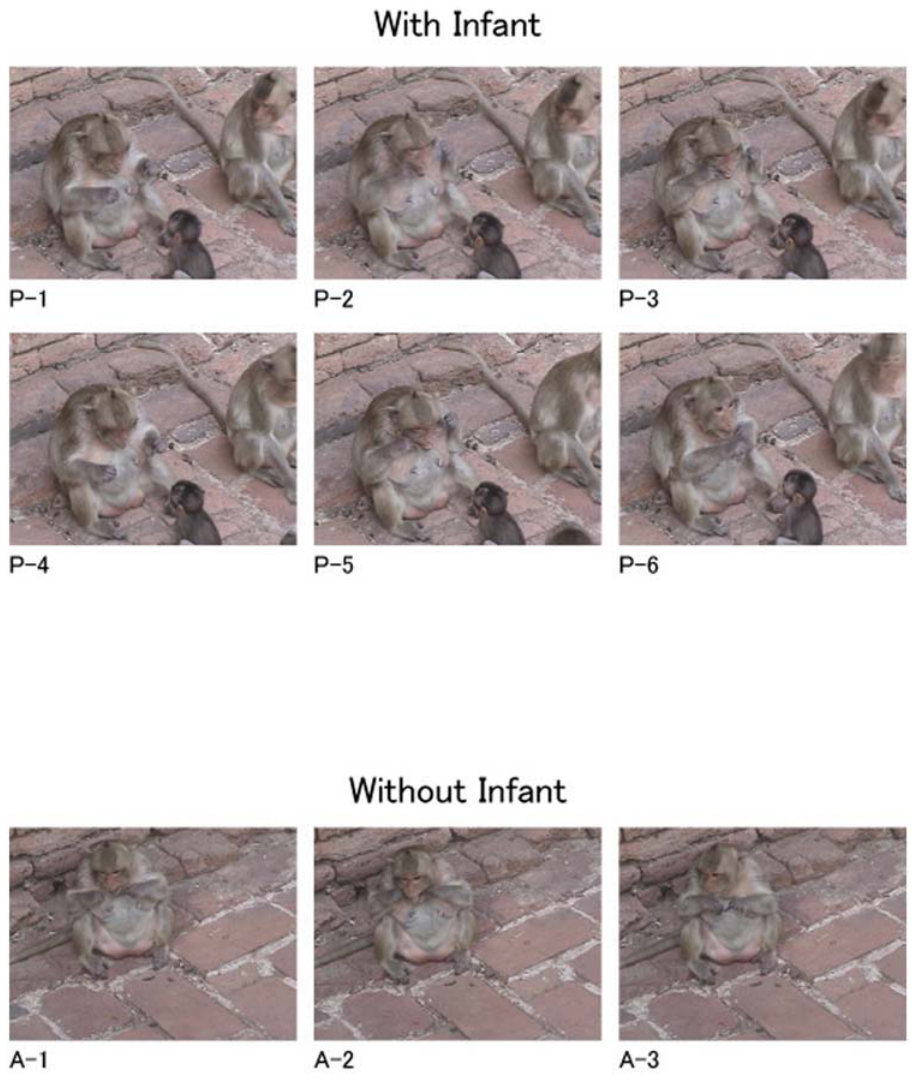
Figure 2. Typical sequences of the action of ‘‘flossing teeth’’. (P 1 to 6) When her infant was in the proximity of an adult female (With Infant; P-1: Grasp the hair taut, P-2: Insert, P-3: Snap, P-4: Look at the hair, P-5: Reinsert, P-6: Pull out). (A 1 to 3) When no animal was in the proximity of an adult female (Without Infant; A-1 Grasp the hair taut, A-2: Insert, A-3: Pull out).